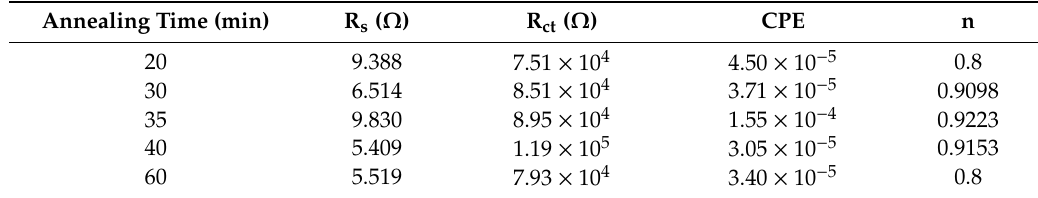
Equivalent circuit parameter values for S32750 stainless steel samples at di ff erent annealing times.